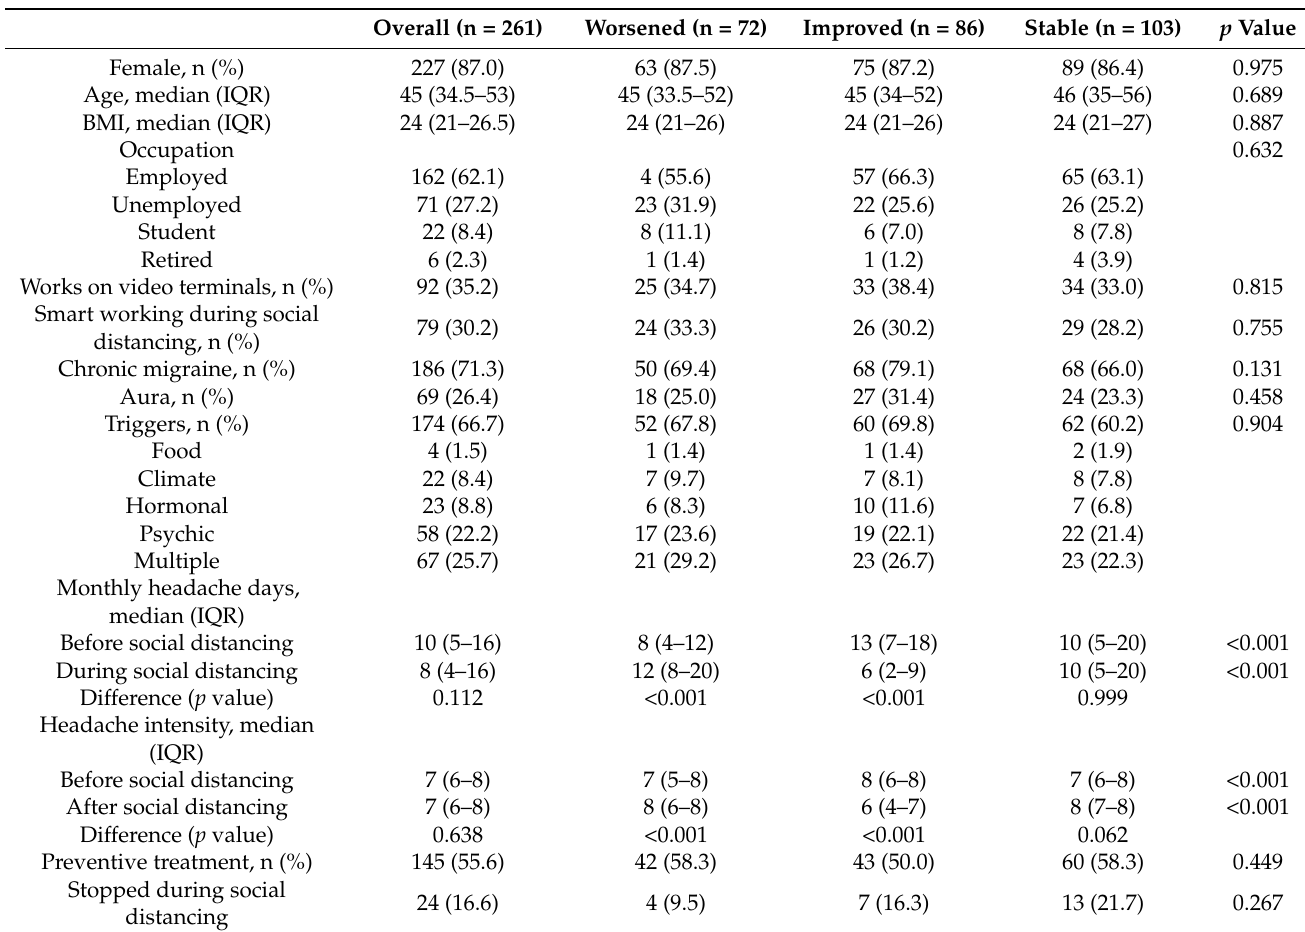
Table 1. Demographic and headache characteristics of the study